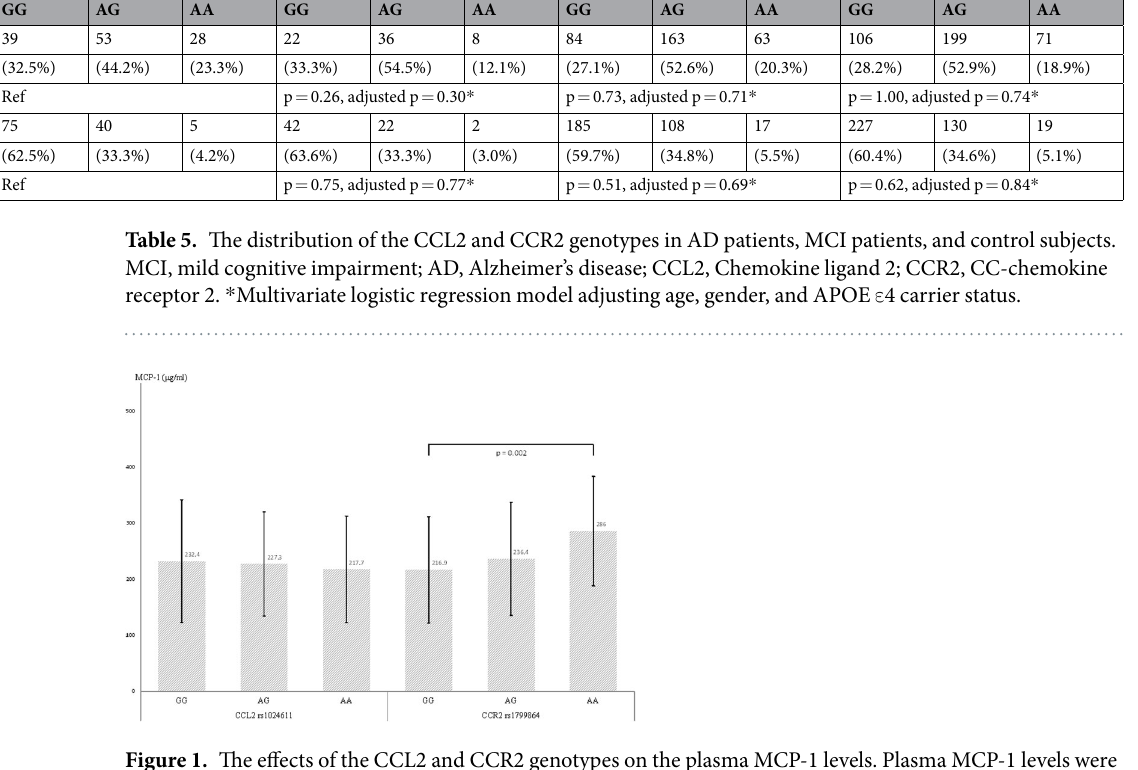
Figure 1. The effects of the CCL2 and CCR2 genotypes on the plasma MCP-1 levels. Plasma MCP-1 levels were similar among the different genotypes of CCL2 rs1024611 in all groups of participants. However, the A allele of CCR2 rs1799864 appeared to exert an additive effect on the plasma MCP-1 levels, with the highest levels observed in the AA genotype, followed by the AG genotype, and the lowest levels were observed in the GG genotype. The p-value was calculated by multiple linear regression models while adjusting for age, sex, APOE ε 4 carrier status, and CCI. The error bars indicate standard deviation. Abbreviations: CCL2, Chemokine ligand 2; CCR2, CC-chemokine receptor 2; MCP-1, Monocyte chemotactic protein-1; APOE, apolipoprotein E; CCI, Charlson comorbidity